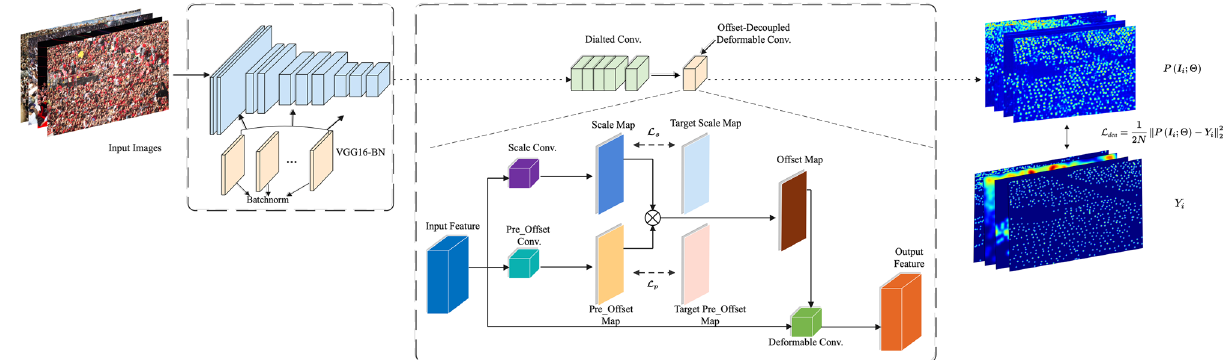
Figure 5. The architecture of the ODConv network. The backbone of CSRNet is replaced with VGG16-BN by inserting the batch normalization layer after each dilated convolution. Then, the last layer of dilated convolution is replaced by offset-decoupled deformable convolution, and the network is defined as our